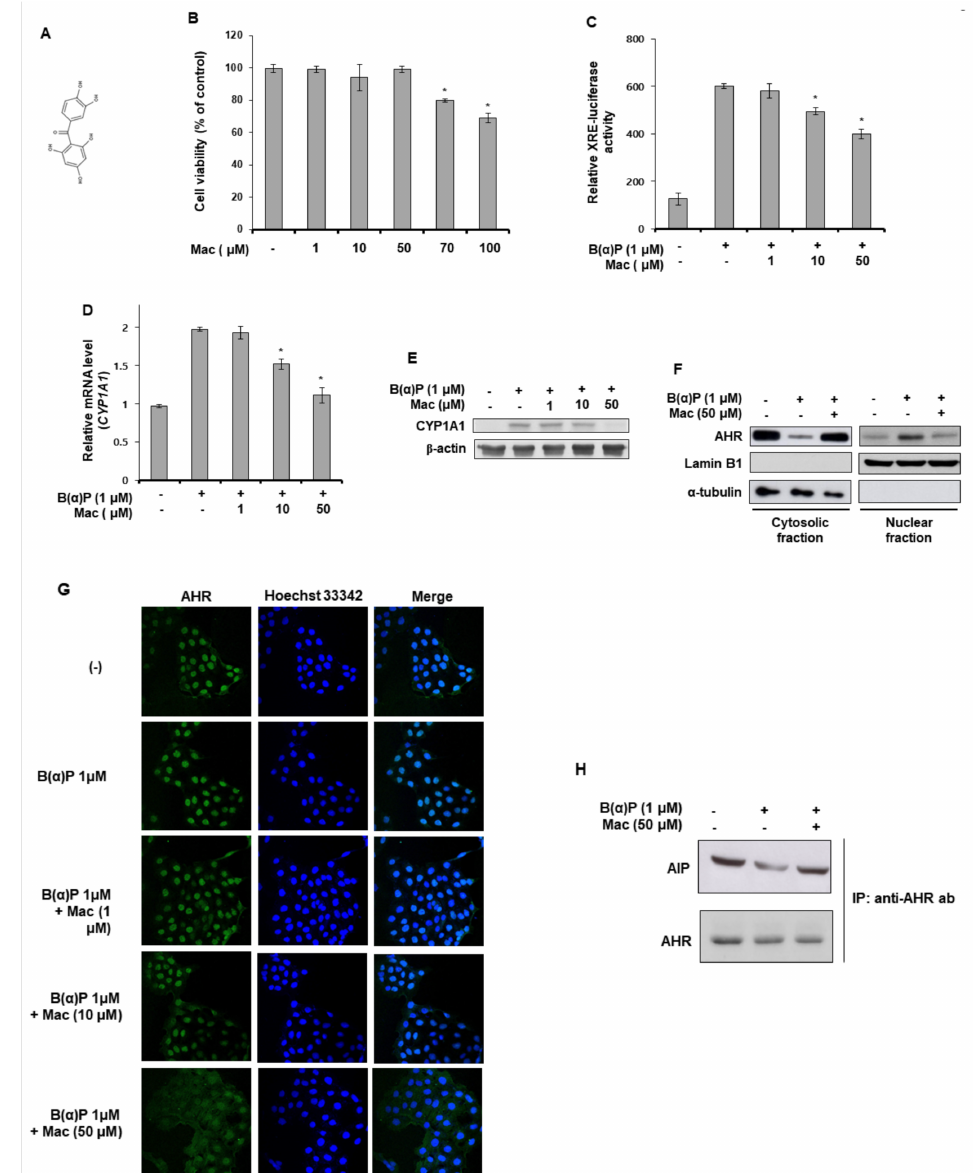
Figure 1. Maclurin suppressed B(a)P-induced aromatic hydrocarbon receptor (AHR) signaling in HaCaT cells. ( A ) Chemical structure of maclurin. ( B ) HaCaT cells were incubated with maclurin. After 24 h of incubation, cells were subjected to cell viability assay. Data are presented as mean ± SD of three replicates. * p < 0.05 versus control group. ( C ) The DharmaFECT ® Duo transfection reagent was used to transfect HaCaT cells with the XRE-Luc reporter together with a Renilla-luciferase vector. After 24 h incubation, the cells were incubated with maclurin and B(a)P under serum-free conditions for 14 h. The cells were lysed and analyzed by the luciferase reporter assay. The data are presented as the mean ± SD of three replicates. * p < 0.05 versus B(a)P treatment group. ( D ) The cells were treated with B(a)P in the presence or absence of maclurin. After 24 h, the cells were harvested and analyzed by RT-PCR ( D ) and Western blots ( E ) for CYP1A1. The data are presented as the mean ± SD of three replicates. * p < 0.05 versus B(a)P treatment group. ( F , G ) HaCaT cells were treated with maclurin and B(a)P for 24 h and analyzed by Western blotting ( F ) of the cytosolic and nuclear fractions and immunocytochemistry (original magnification: 20X) ( G ) to assess AHR translocation. ( H ) HaCaT cells were treated with maclurin and B(a)P for 24 h and analyzed by immunoprecipitation with anti-AHR antibodies and Western blotting of AIP and AHR. Mac: